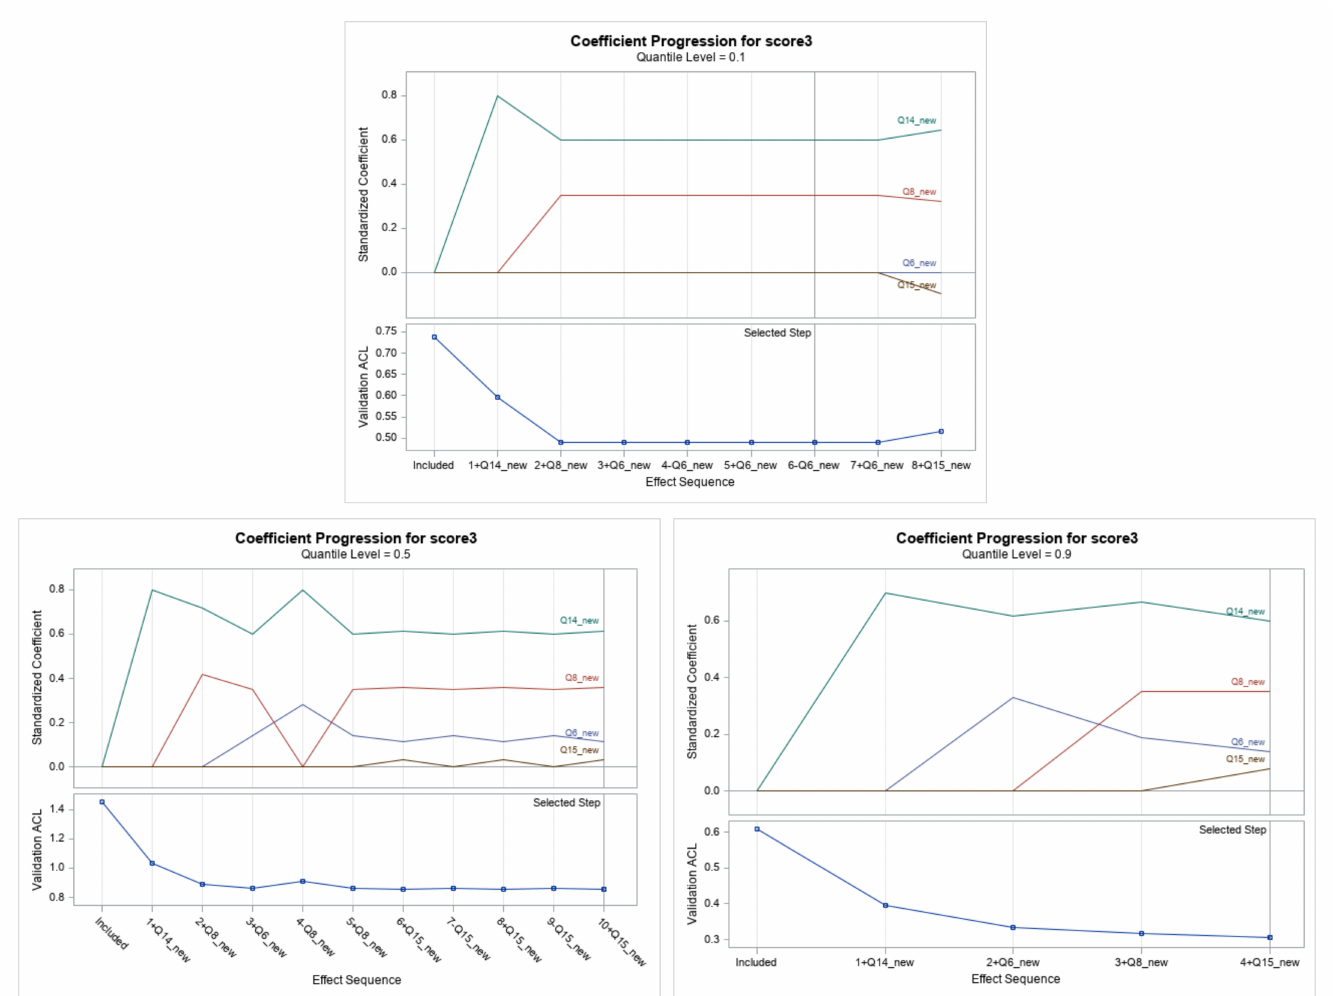
Figure 3. Plots of coefficient progression plots for Score 3 at 0.05, 0.1, 0.5, and 0.90